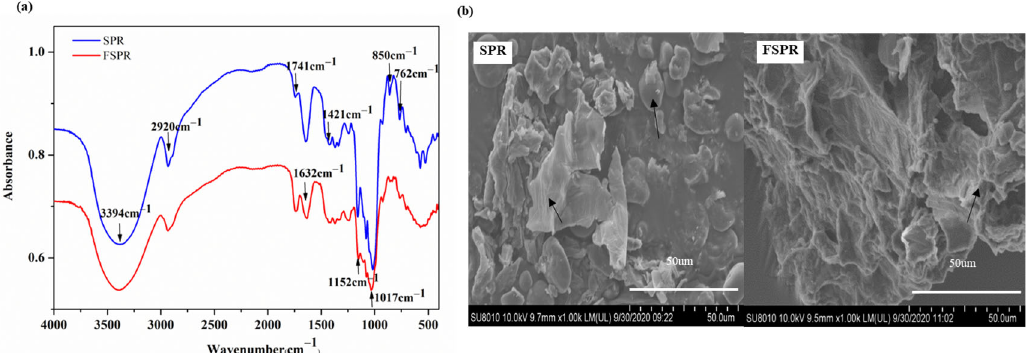
Figure 2. The FTIR spectrum ( a ) and scanning electron microscopy images ( b ) of sweet potato residues fermented with combined strains; SPR: Sweet potato residues; FSPR: Sweet potato residues fermented under optimal process; Arrows: the representative morphological structure of starch and dietary fiber in the images.